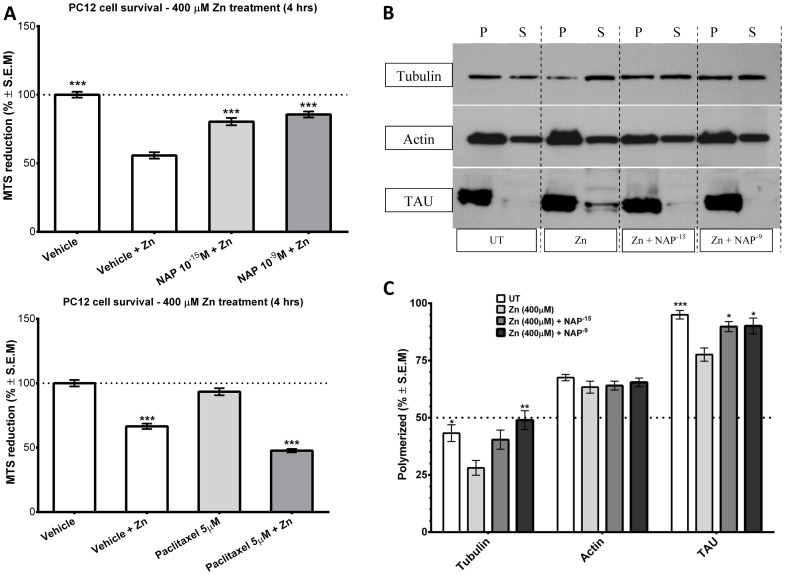
NAP enhances tau-microtubule interactions and microtubule polymerization under zinc intoxication.(a) Zinc exposure (400 µM) resulted in PC12 cell death which was protected against by NAP treatment. Results of mitochondrial activity (MTS cell viability) are shown –100– is 100% survival – control w/o zinc treatment. (ANOVA, ***p<0.0001, n = 18/group, post hoc comparison were made in reference to vehicle+Zn treatment), upper panel. The lower panel shows a similar experiment with 5 µM paclitaxel (ANOVA, ***p<0.0001, n = 10/group, post hoc comparisons made in reference to vehicle, or to vehicle+Zn treatment). (b) Cell lysates were separated into polymerized (P) or soluble (S) protein fractions as in Figure 2. Aliquots of equal volumes for each pair were separated on adjacent lanes by SDS polyacrylamide gel electrophoresis, the blot was probed with antibodies recognizing α-tubulin, or total tau or actin and the percentage of the polymerized fraction was calculated for each ‘P’ and ‘S’ pair. (c) The intensity of each band was quantified by densitometry, and the percentage of the polymerized fraction was determined. (Actin, ANOVA, p = 0.4774, n = 6; Tubulin, ANOVA, p = 0.007, n = 6; TAU, ANOVA, p = 0.0022, n = 5, post hoc determinations were against the zinc-treated group for each of the variables).